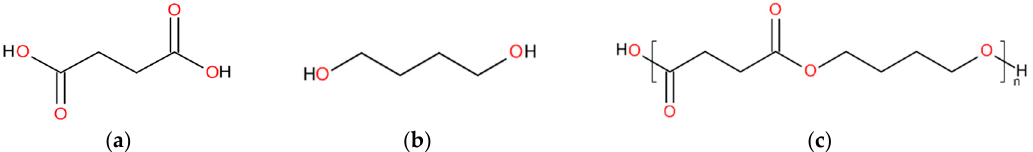
Figure 1. Chemical structure of ( a ) PLLA and ( b ) PDLA.